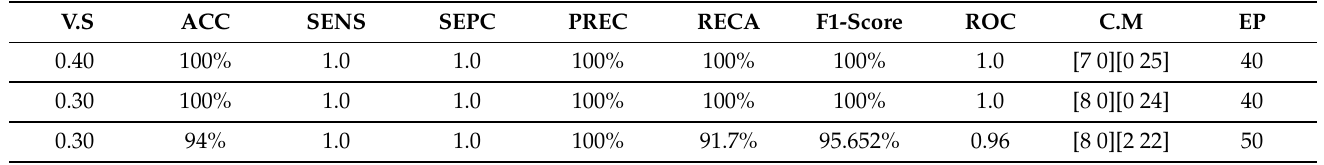
Table 4. Adam’s rate of learning is = 0.001. The loss function is binary cross entropy (BCE).